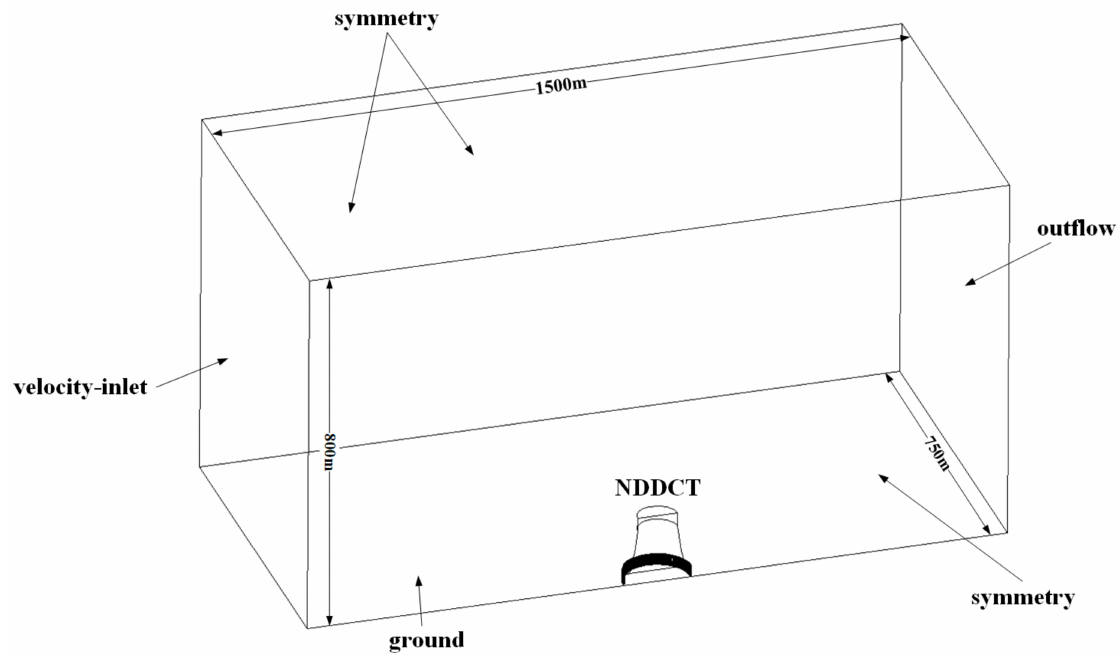
Figure 5. Computational domain and boundary conditions of natural draft dry cooling tower